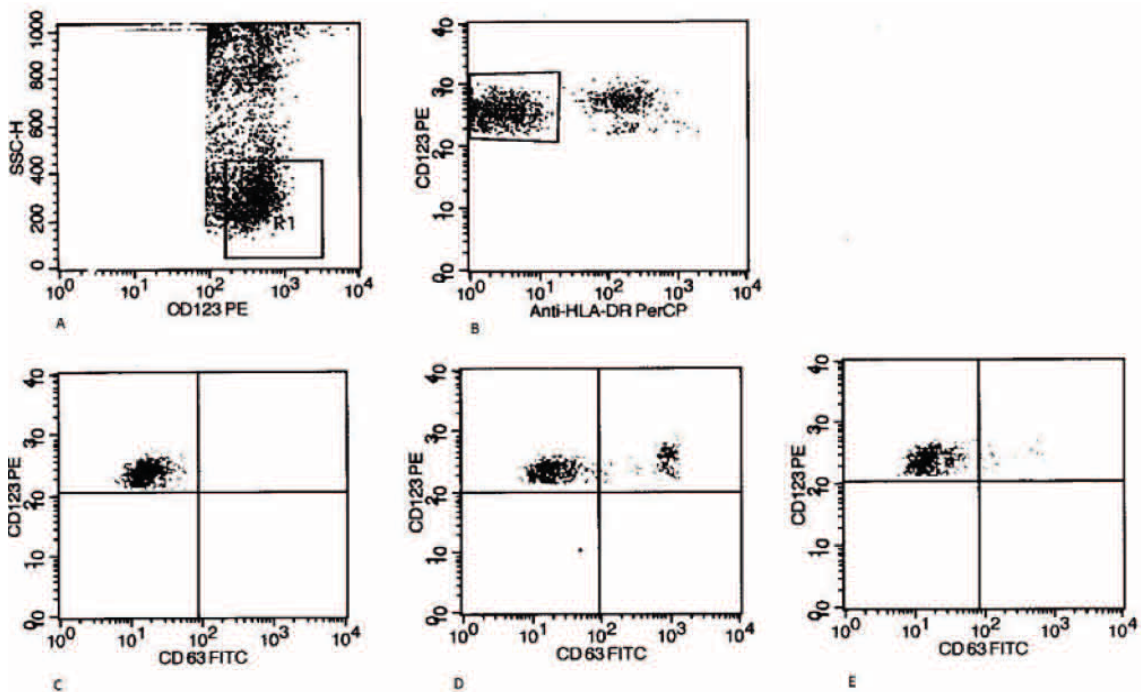
Figure 1. Basophil identification and expression of CD63. Basophils were gated with R1 and R2 (boxed area). Gate R1 (A) isolates the low side scatter (SSC), CD123+ basophils population. Gate R2 (B) detects a well defined population of cells highly positive for CD123, but negative for HLA-DR. Histogrames of CD63 expression after addition of buffer (PBS) for negative control (C), fMPL for positive control (D) and patient sera